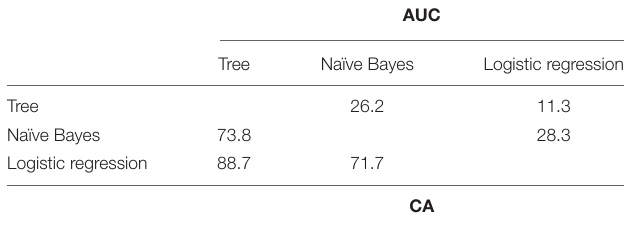
TABLE 4 | Comparison of the performance measures among classification algorithms through Bayesian interpretation of the pairwise Student’s t